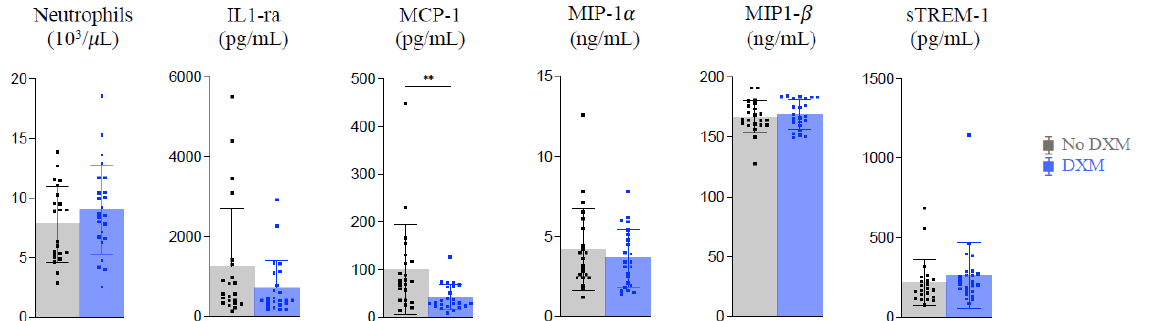
Figure 5. Corticosteroid e ff ects on lymphoid immune response in critical COVID-19 patients. Sca tt er graphs of lymphoid in fl ammatory cytokines. Individual values (dots), mean (colored rectangle), and standard deviation are presented on the graphs. ** p < 0.01, **** p < 0.0001 between the no DXM group and the DXM group. CD40L, CD40 ligand; IFN γ , interferon gamma; IL, interleukin; IP-10, interferon gamma-induced protein 10. Figure 6 provides an overview of corticosteroid e ff ects on the in fl ammatory and im- mune responses, endothelial and platelet activation, NETosis, and coagulopathy in pa- tients with severe COVID-19.